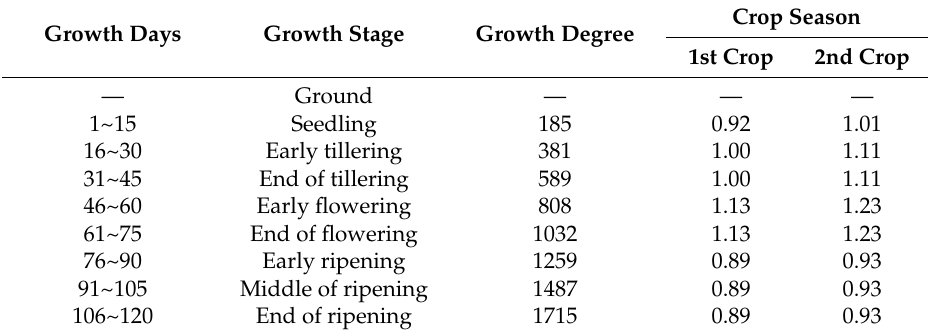
Table 1. Paddy rice crop coefficient (K c ) for each growth stage adopted from Yao et al.